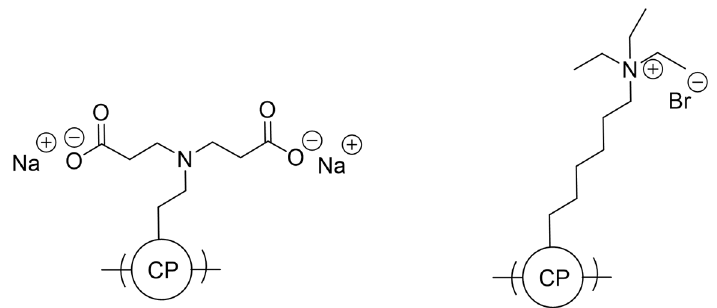
Figure 16. Structures of anionic and cationic conjugated polyelectrolytes to illustrate ionic component of the side-chains (CP = conjugated polymer) [107].